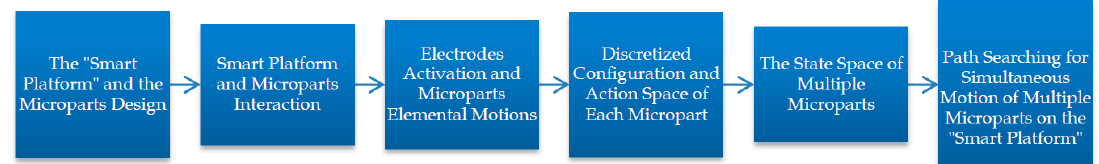
Figure 1. The proposed approach for simultaneous manipulation of multiple microparts step-by-step.